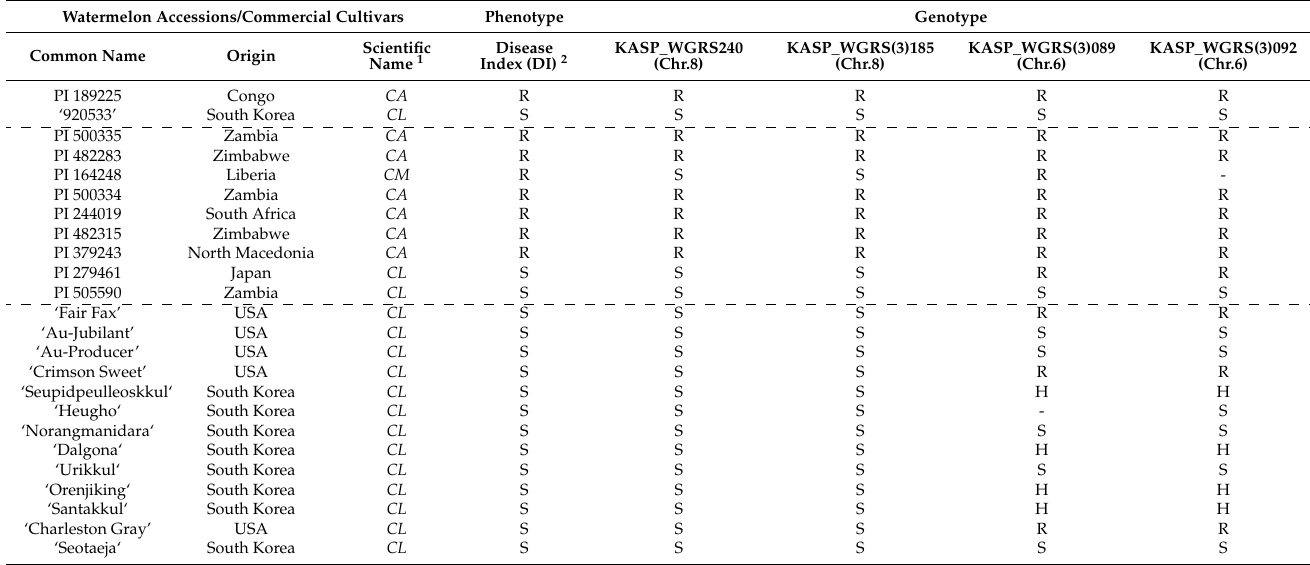
Table 4. Validation of KASP™ markers developed for the gummy stem blight (GSB) resistance in QTL